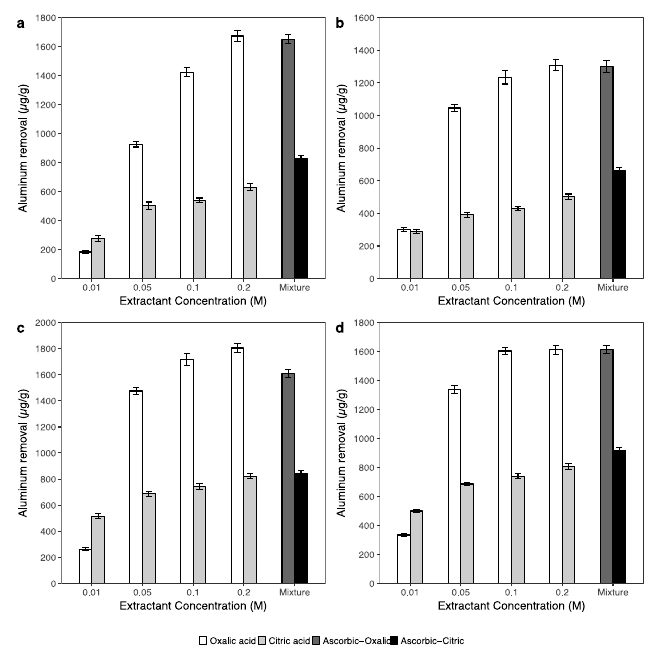
Figure 3. Extracted aluminum under the effect of oxalic and citric acid in various concentrations (from 0.01 M to 0.2 M), and the combination of 0.1 M ascorbic with 0.2 M oxalic, and the combination of 0.1 M ascorbic with 0.2 M citric acid in river bed sediment ( a ), mangrove forest soil ( b ), paddy soil ( c ) and aquaculture farm sediment ( d ).